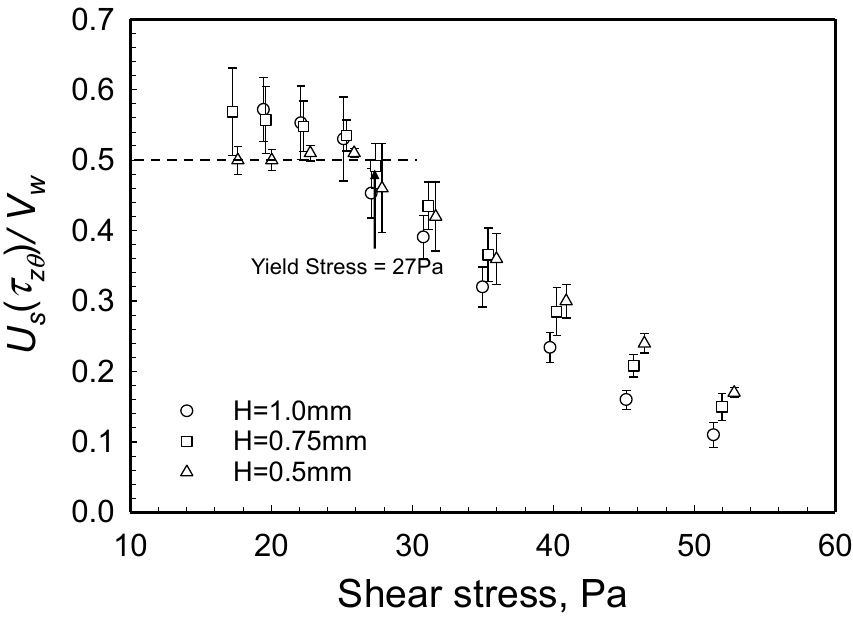
Ω U , over the plate velocity, Vw = R ,versus shear stress at the edge, = 0.5 corresponds to plug R = 0.5 corresponds to plug flow. R Ω